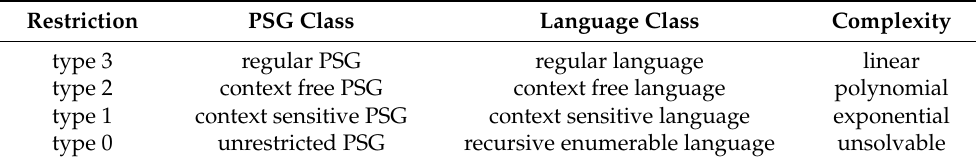
Table 1. PS-grammar (Phrase Structure grammar) hierarchy of formal languages according to [35]. Restriction PSG Class Language Class Complexity type 3 regular